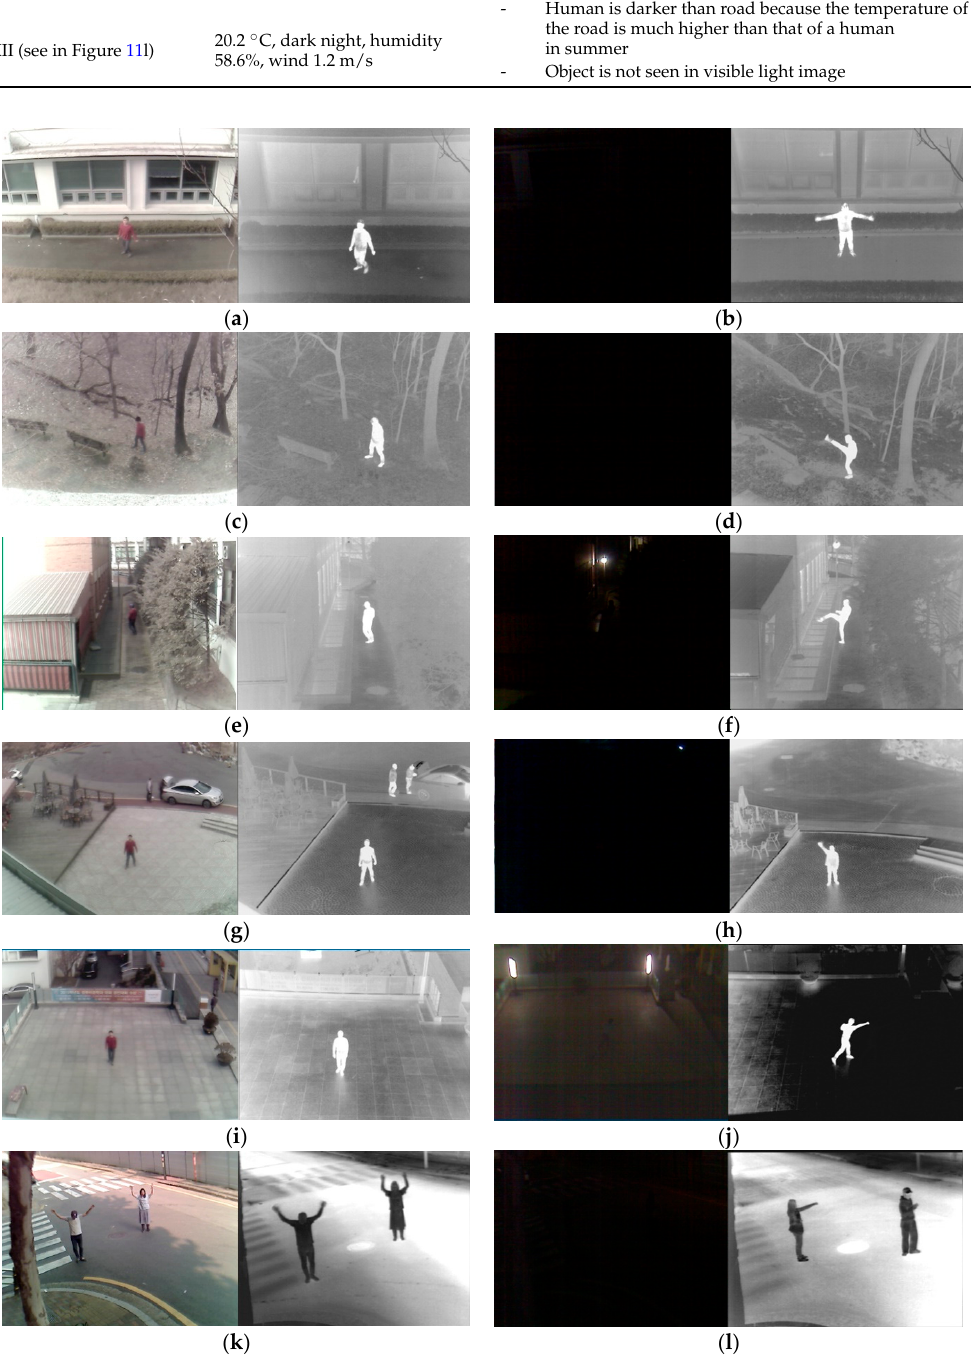
Figure 11. Examples from each of the 11 datasets. ( a ) Dataset I; ( b ) dataset II; ( c ) dataset III; ( d ) dataset IV; ( e ) dataset V; ( f ) dataset VI; ( g ) dataset VII; ( h ) dataset VIII; ( i ) dataset IX; ( j ) dataset X; ( k ) dataset XI; ( l ) dataset XII.